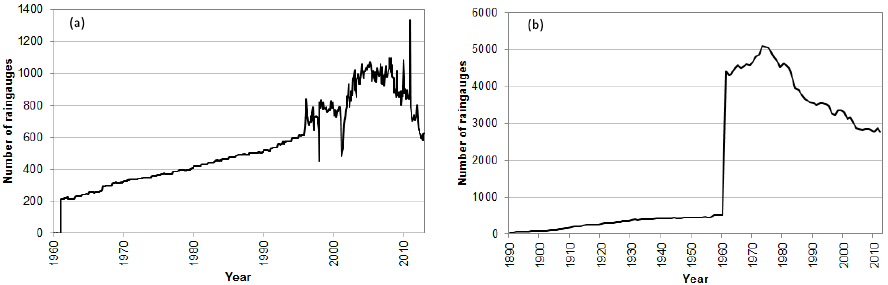
Figure 2. Evolution of number of rain gauges in the UK within the network used to derive CEH-GEAR rainfall grids for (a) monthly rain gauges (1960 to 2012, prior to 1961 only one monthly rain gauge) and (b) daily rain gauges (1890 to 2012).